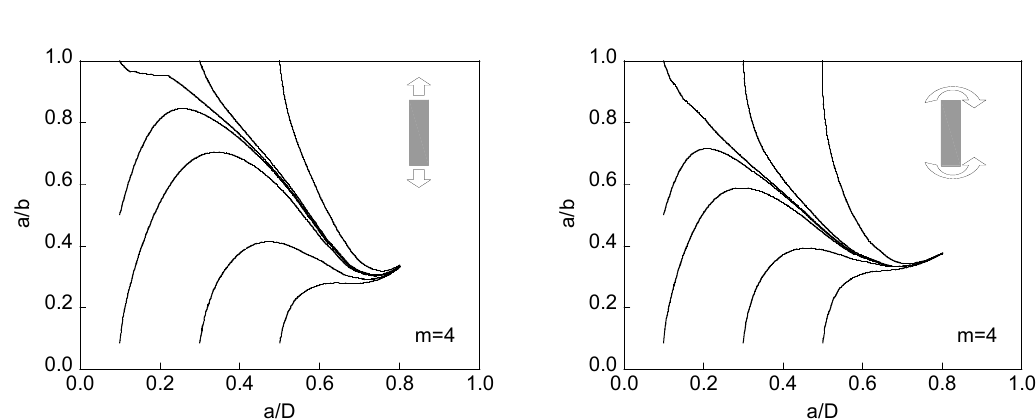
Figure 7: Evolution of the aspect ratio a / b with crack growth (represented by the relative crack depth a / D ) for m =4, starting from different initial crack geometries under tension loading (left) and bending moment (right).